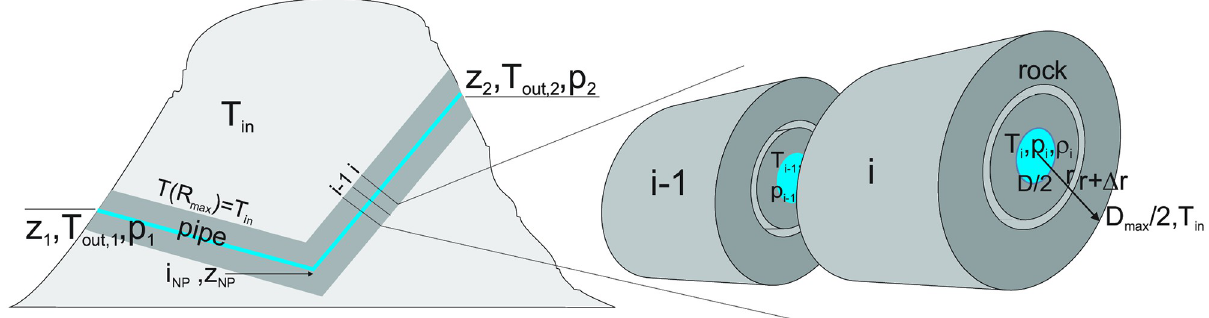
Fig 5. Left: Geometry and parameters of the system. The passage is shown by the blue line. Right: Excerpt with two pipe segments and the surrounding cylindrical rock mass.